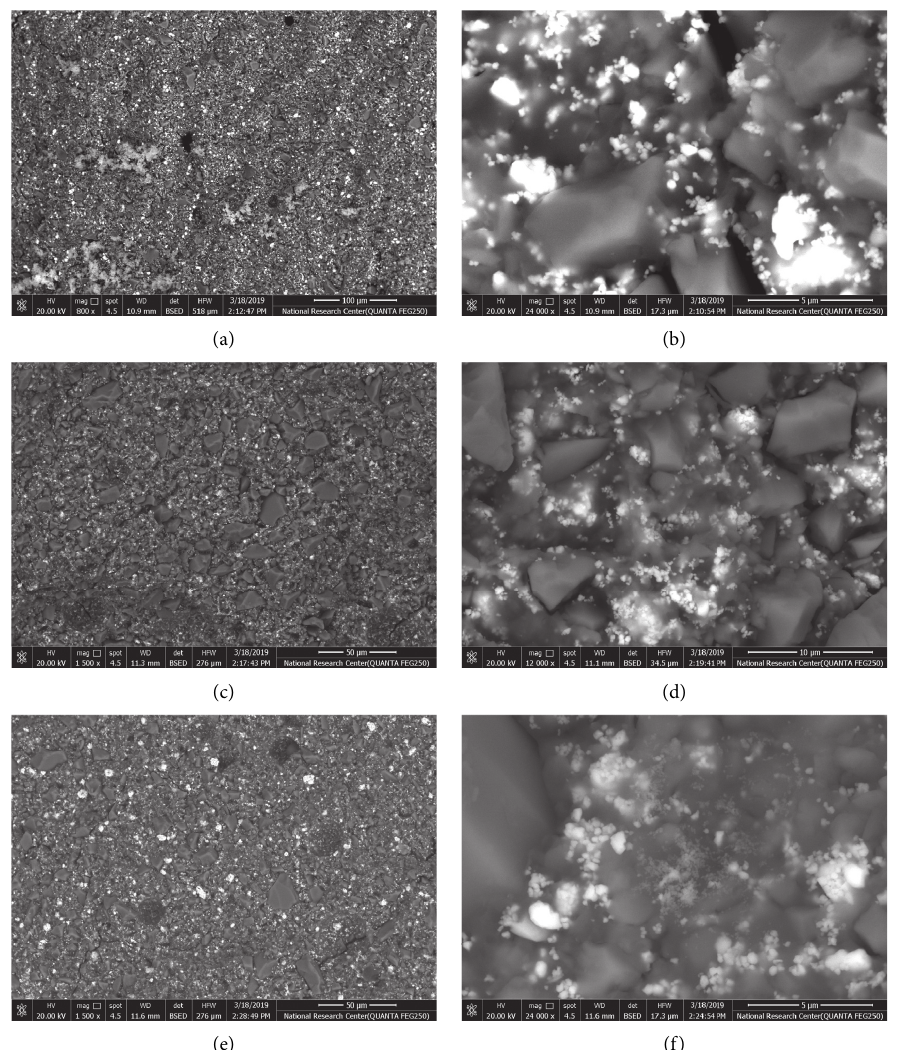
Figure 3: Scanning electron micrographs of studied groups’ samples at low (a, c, and e) and high magnifications (b, d, and